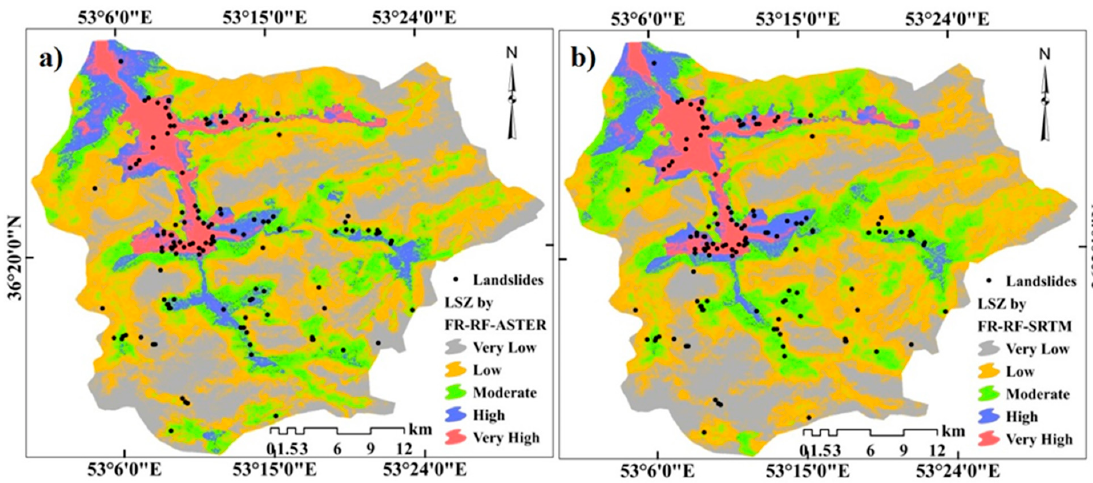
Figure 8. LSMs using ( a ) FR–RF–ASTER approach and ( b ) FR–RF–SRTM approach.